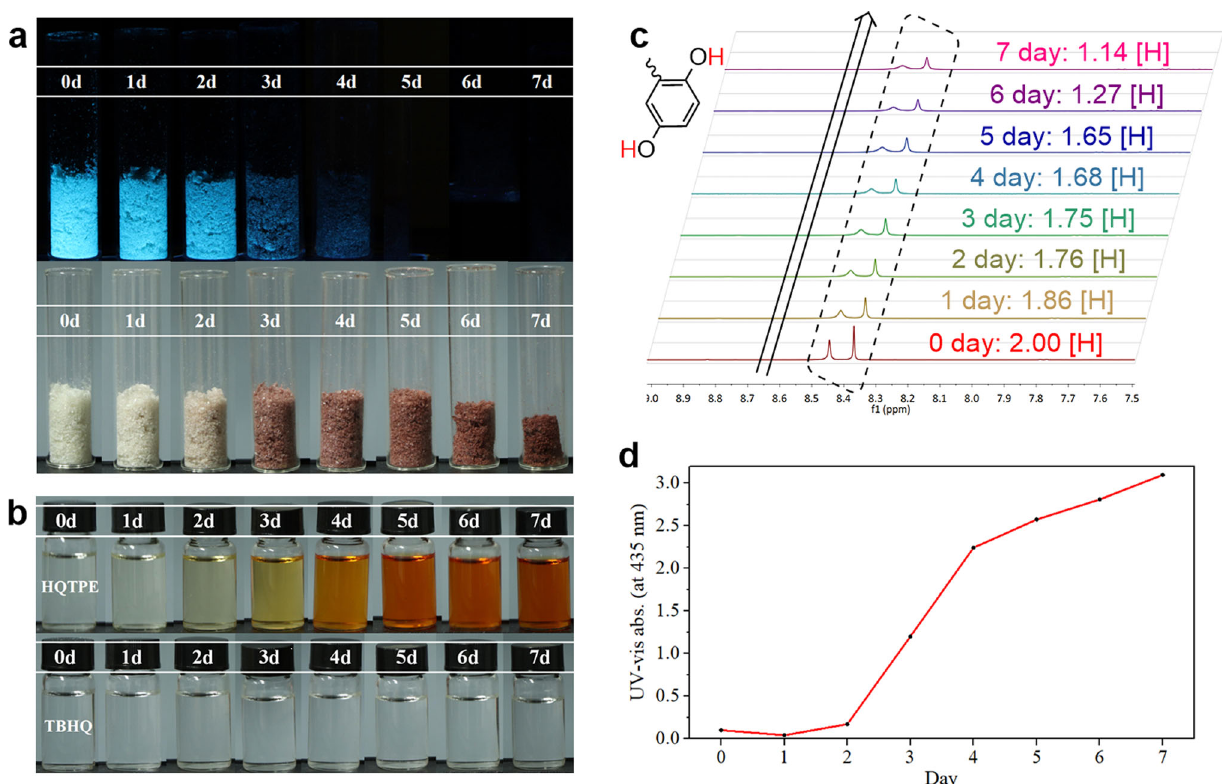
Fig. 9 Oxidation process of HQTPE with exposure to ambient condition. a Photographs of HQTPE powder exposed to air within 7 days under exposure to 300 nm UV light or white light. b Photographs of HQTPE and TBHQ solutions exposed to air within 7 days under white light. HQTPE exhibits much better deoxygenation activity than TBHQ. c 1 H NMR spectras in DMSO-d 6 of HQTPE solution. There was a clear decrease of phenol hydrogens at 8.4 p.p.m. after the week-long exposure to air. The same test was also performed on TBHQ, thus ruling out the possibility of hydrogen-deuterium exchange. d Change in the intensity of absorption band at 435 nm of HQTPE solution upon exposure to air within 7